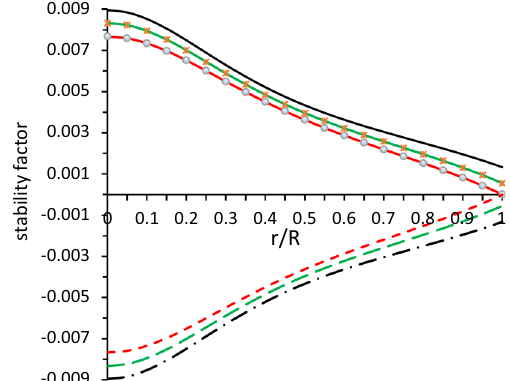
Fig. 6 The trend of stability factors corresponding to v 2 r − v 2 t (solid lines) and v 2 t − v 2 r (dashed lines) verses the radial coordinate r / R . The description of the compact objects are as follows: PSR J1614-2230 (black curve) for α = 0 . 001, 4U1608-52 (green curve) for α = 0 . 0012, and Cen X-3 (red curve) for α = 0 . 0014. The numerical values of the free parameters a , b , β and γ are same as used in Fig. 4